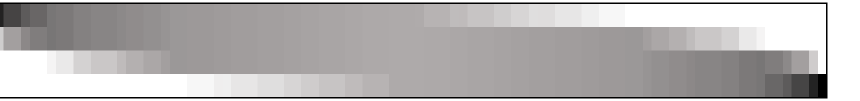
Figure 4. Graphical representation of the probability mass distribution of the Weighted Diamond algorithm as a heat map, where a probability of one gives black values and zero white